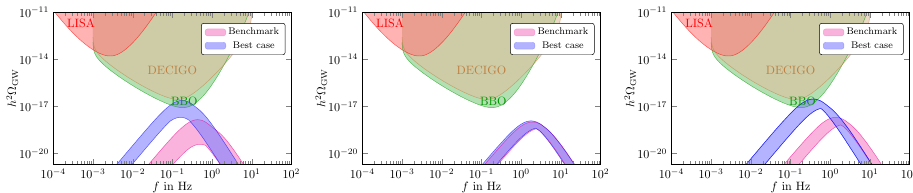
Figure 3. GW spectra of the chiral / confinement phase transition of SU(3) with N f = 3 fundamental quarks (left), N f = 1 adjoint quarks (middle), and N f = 1 two-index symmetric quarks (right) for a benchmark scenario and the best-case scenario in the parameter space. Figures taken from